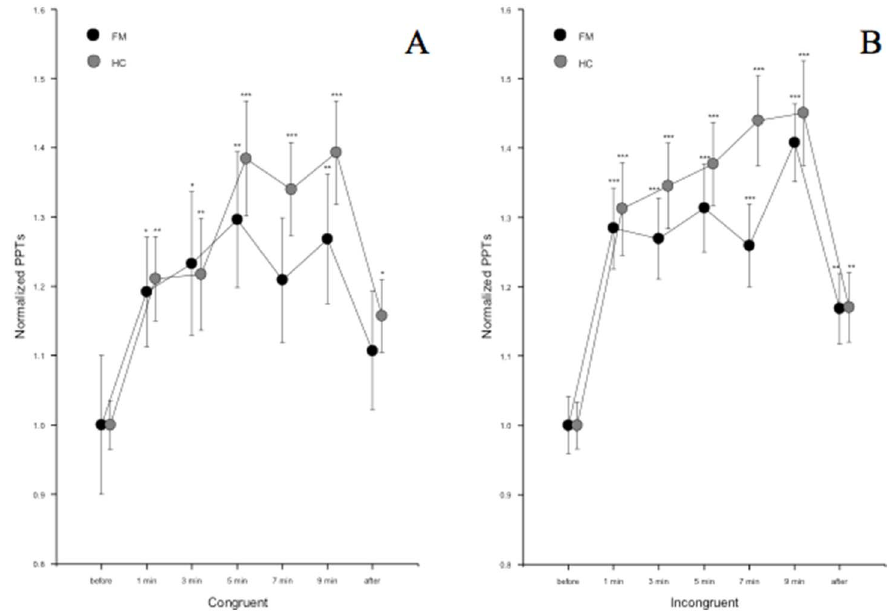
Figure 2. Average normalized PPTs ± SEM during a) congruent and b) incongruent SCWT in FM patients and HC. PPTs increased in both groups alike during congruent as well as incongruent SCWT. There were no statistically significant differences between congruent and incongruent SCWT regarding the modulation of PPTs. *=p , 0.05, **=p , 0.01, ***=p , 0.001. The normalization was performed as follows: each PPT value was divided with the individual’s first PPT at baseline and the curves were adjusted (by adding a coefficient) so that the baseline value always corresponded to 1.